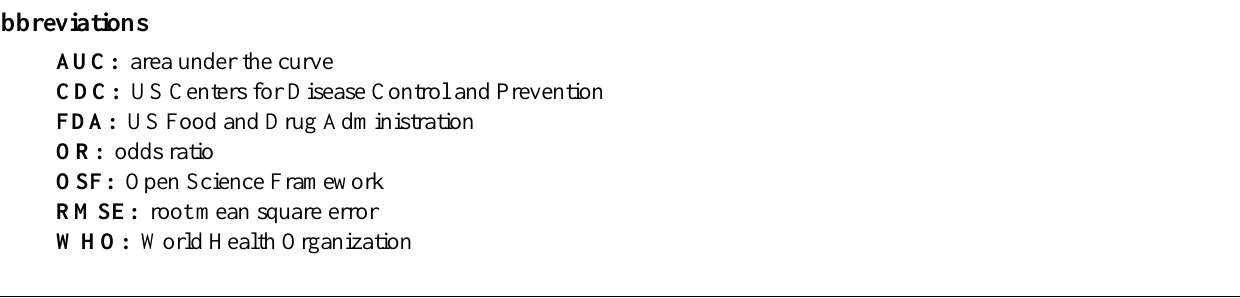
Abbreviations AUC: area under the curve CDC: US Centers for Disease Control and Prevention